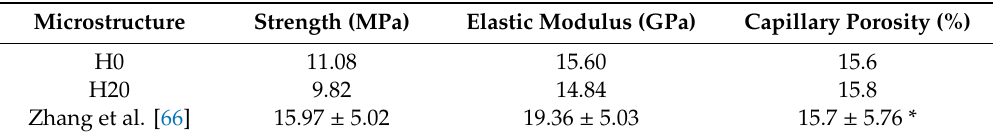
Figure 5. Simulated stress / strain curves for cement paste microstructures subjected to simulated uniaxial tension. Table 3. Uniaxial strength and elastic modulus of simulated microstructures determined by micromechanical simulations. For comparison, results from our previous work are given (note that, there, the microstructure was determined using X-ray CT).